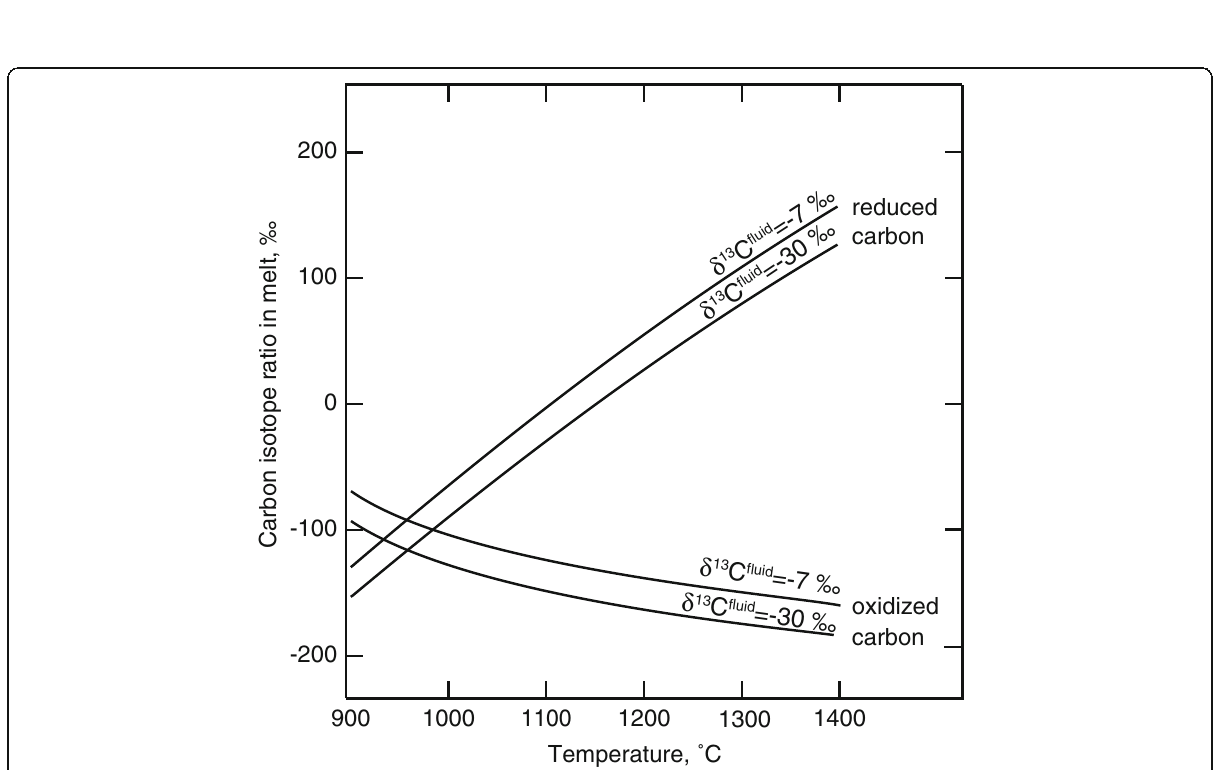
Fig. 11 Carbon isotope ratio in melt in equilibrium with fluid with isotope ratios as indicated under reducing and oxidizing conditions as a function of temperature (data from Mysen 2016, 2017)